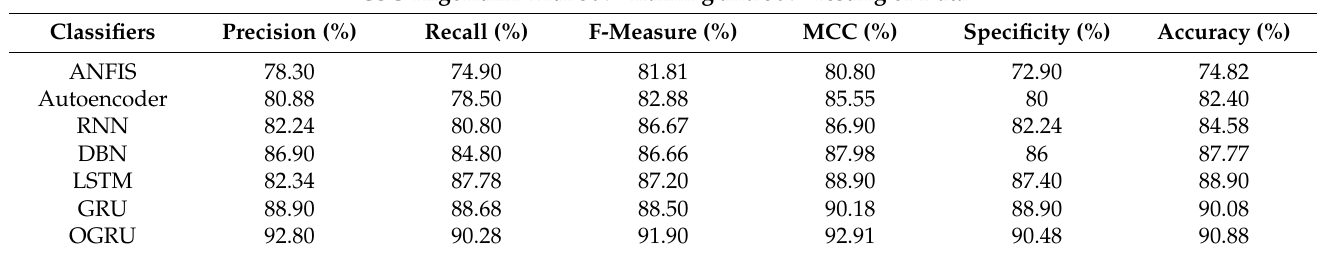
Table 1. Simulation results of the proposed model by varying the classifiers with 50:50% training and testing of data.